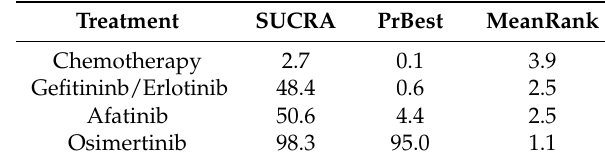
Table 2. Network meta-analysis in PFS among chemotherapy, gefitinib or erlotinib, afatinib and osimertinib. Treatment